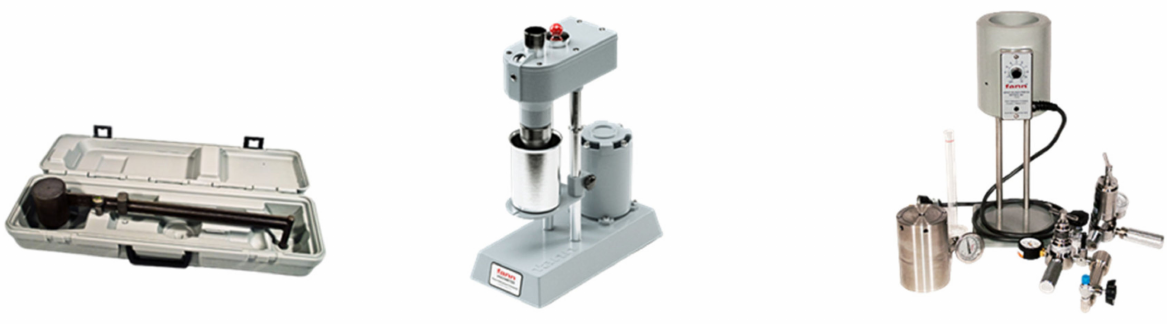
Figure 1. Laboratory